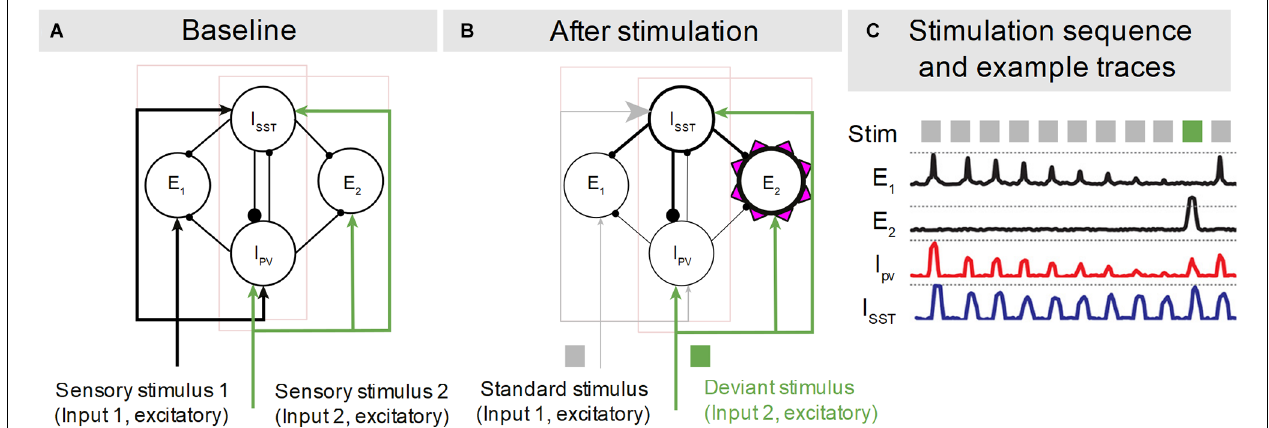
FIGURE 2 | Hypothetical model of mismatch negativity microcircuitry based on electrophysiology and tracing studies in mice. (A) In its baseline state interconnected excitatory populations (E 1,2 ) respond similarly to the stimuli (black and green bottom-up arrows) they are selective for, with no relevant modulation from local interneurons (which are not stimulus selective). (B) After repeated stimulation the standard-selective pyramidal population (E 1 ) reduces its excitability due to inherited adaptation from the upstream sensory input, and the deviant-selective population (E 2 ) increases its excitability due to NMDA-mediated (purple triangles) synaptic potentiation. Circles indicate neural populations and lines their connectivity. Arrows and filled circles indicate excitatory and inhibitory synapses, respectively. Thickness is used to indicate the strength of synaptic connectivity (arrows and filled circles) and stimulus response (circles and lines). I SST and I PV indicate somatostatin and parvalbumin interneurons, respectively. Excitatory and inhibitory populations that respond preferentially to the same stimuli are grouped and surrounded by light pink rectangles. Only the relevant connectivity is shown. (C) Typical activity traces for these neural populations as they transition from baseline to adapted activity (E 1 , I PV ), including responses (E 2 ) to a deviant during an oddball paradigm. Grey and green squares indicate the stimulus sequence. Adapted from Ross and Hamm